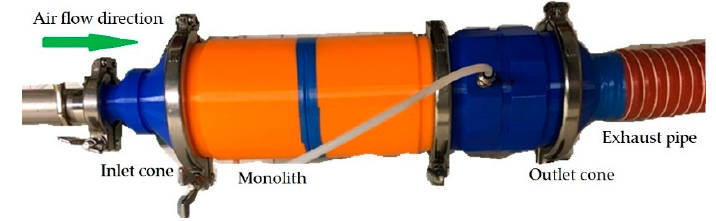
Figure 5 . The cone and monolith.